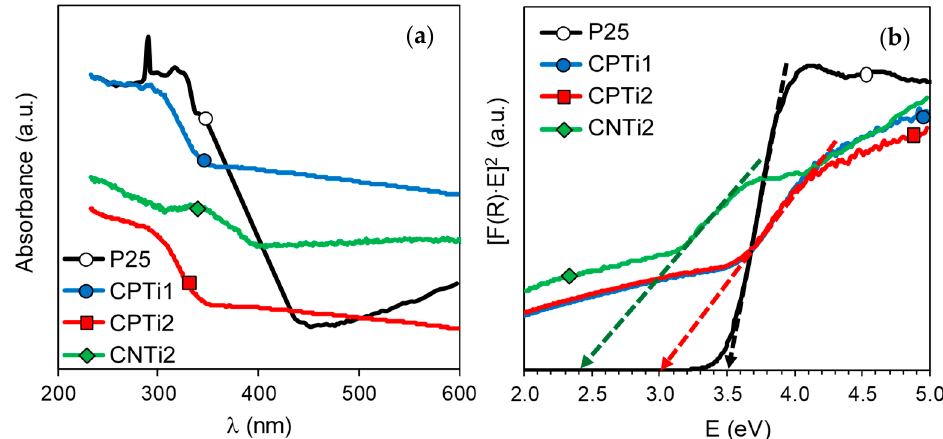
Figure 7. ( a ) UV/Vis diffuse reflectance spectra (DRUV) of P25 and different carbon–Ti composites. ( b ) Plot of transformed Kubelka–Munk units as a function of the energy of light (inset: determination of the band gap).